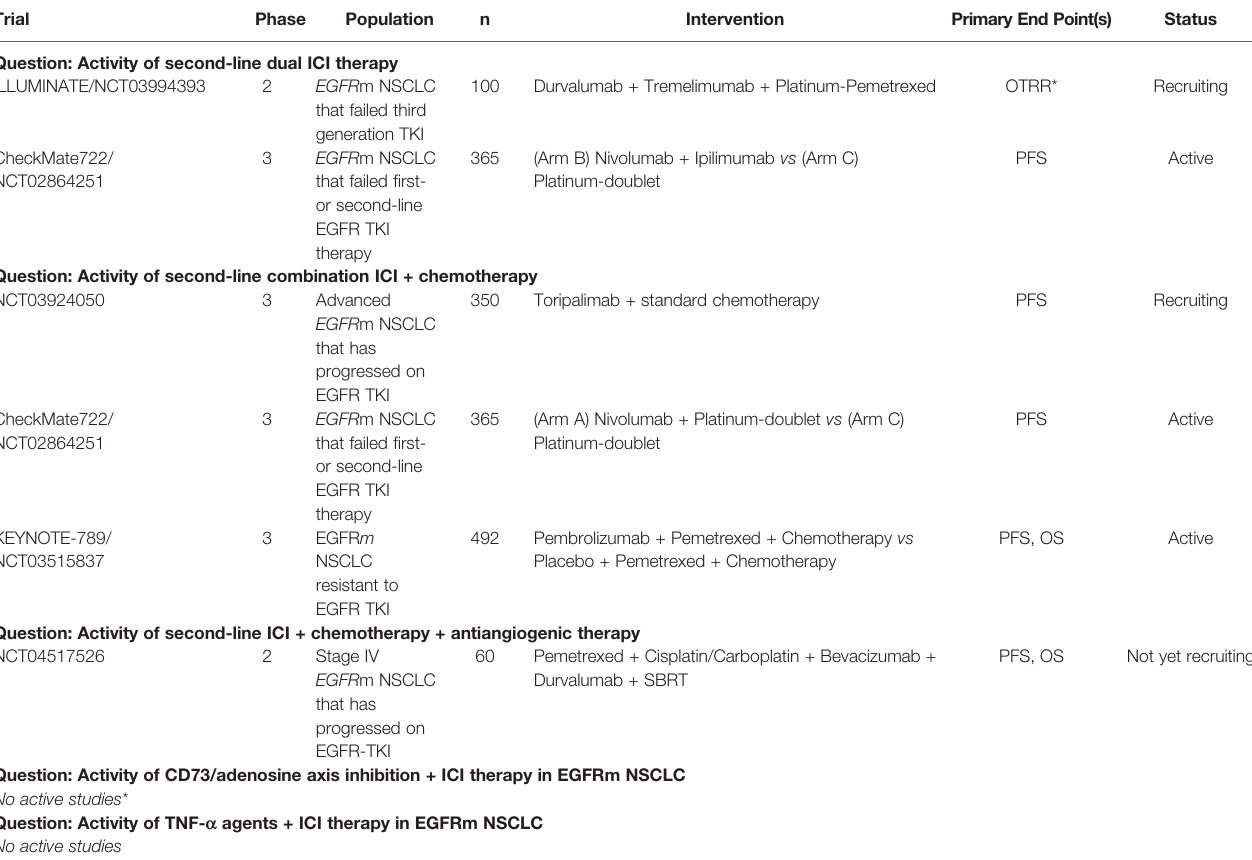
TABLE 3 | Active or planned clinical trials addressing important questions of ICI use in advanced EGFR m NSCLC. Trial Phase Population n Intervention Primary End Point(s) Status